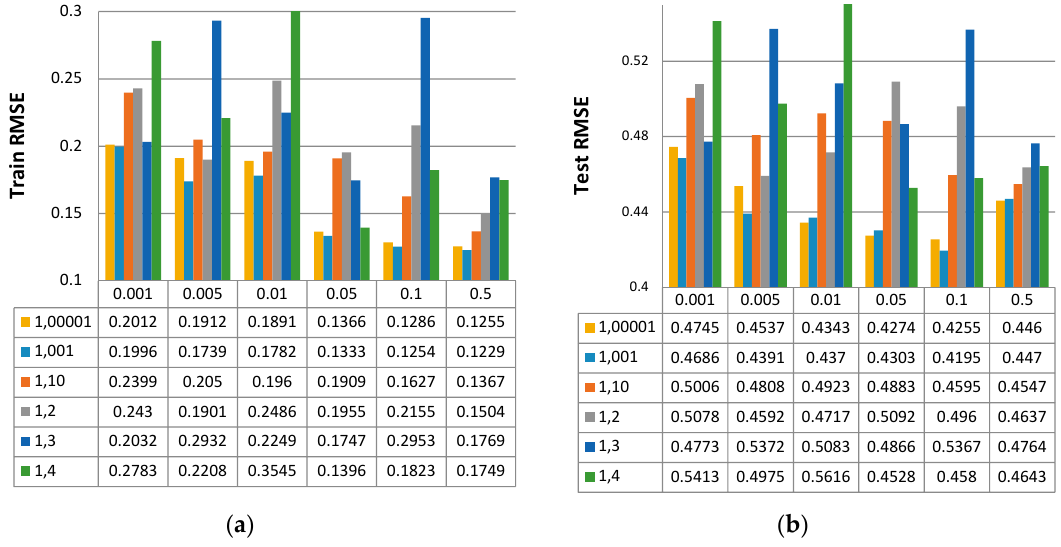
Figure 7. ANFIS model train (a) and test RMSE accuracies (b) . Structures were trained with back-propagation for 100 epochs, two Gaussian MFs per input, different initial step sizes and different step size increase rates.